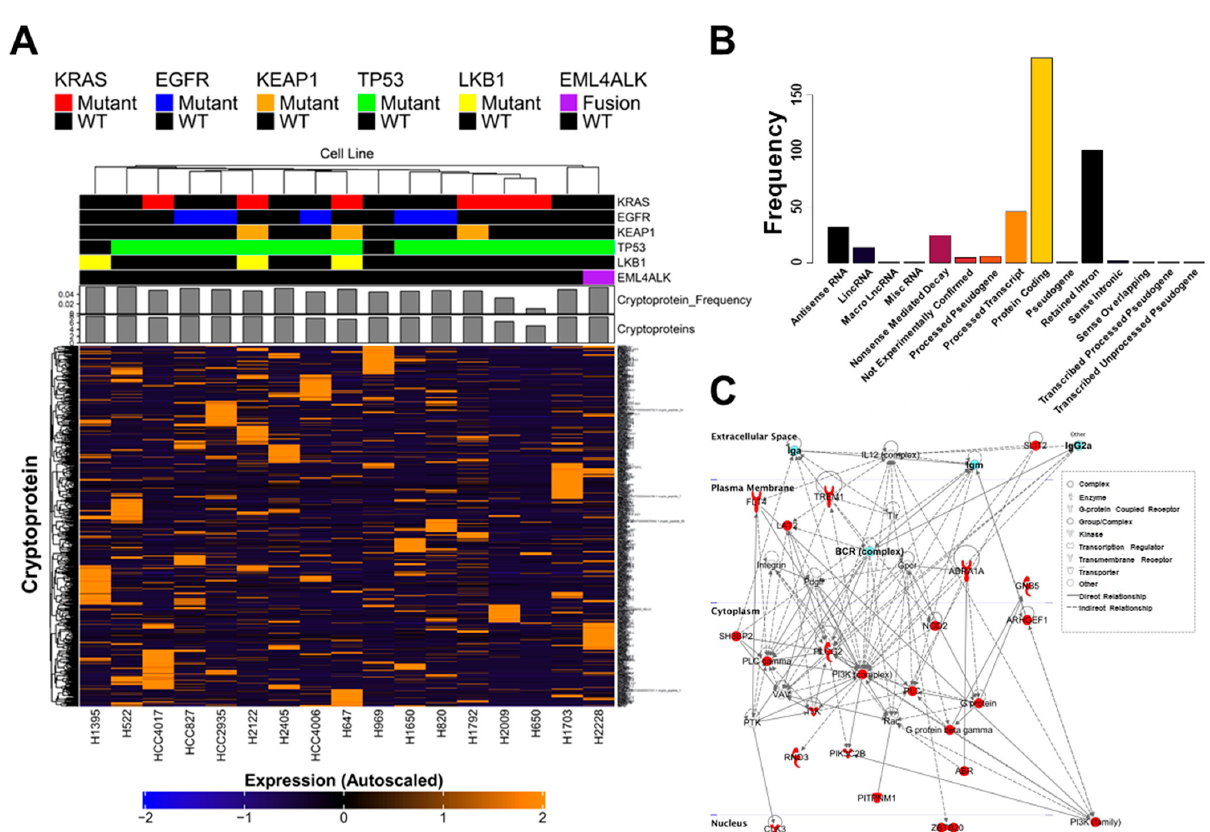
Figure 1. Cryptoproteins are widely detected in human lung adenocarcinoma cell lines: ( A ) A heatmap representation of cryptoprotein expression in lung adenocarcinoma cell lines with annotated driver mutation (KRAS, EGFR, KEAP1, TP53, LKB1, EML4/ALK) shows no association between mutational status and cryptoprotein production. ( B ) Cryptoproteins identified and quantified in lung adenocarcinoma cell lines. ( C ) Ingenuity pathway analyses of genes corresponding to the 420 cryptoproteins detected in lung adenocarcinoma cell lines revealed enrichment of inflammatory pathways with B-cell receptor and immunoglobulin families as central network nodes.